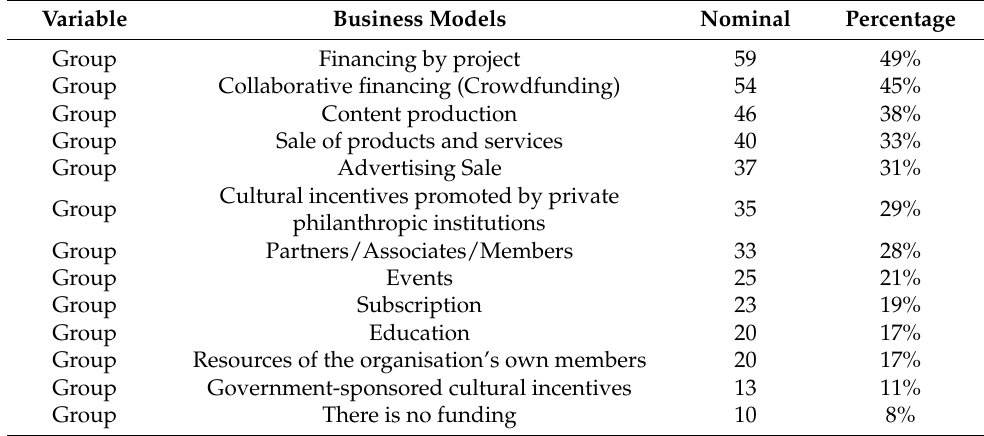
Table 23. Business Models.